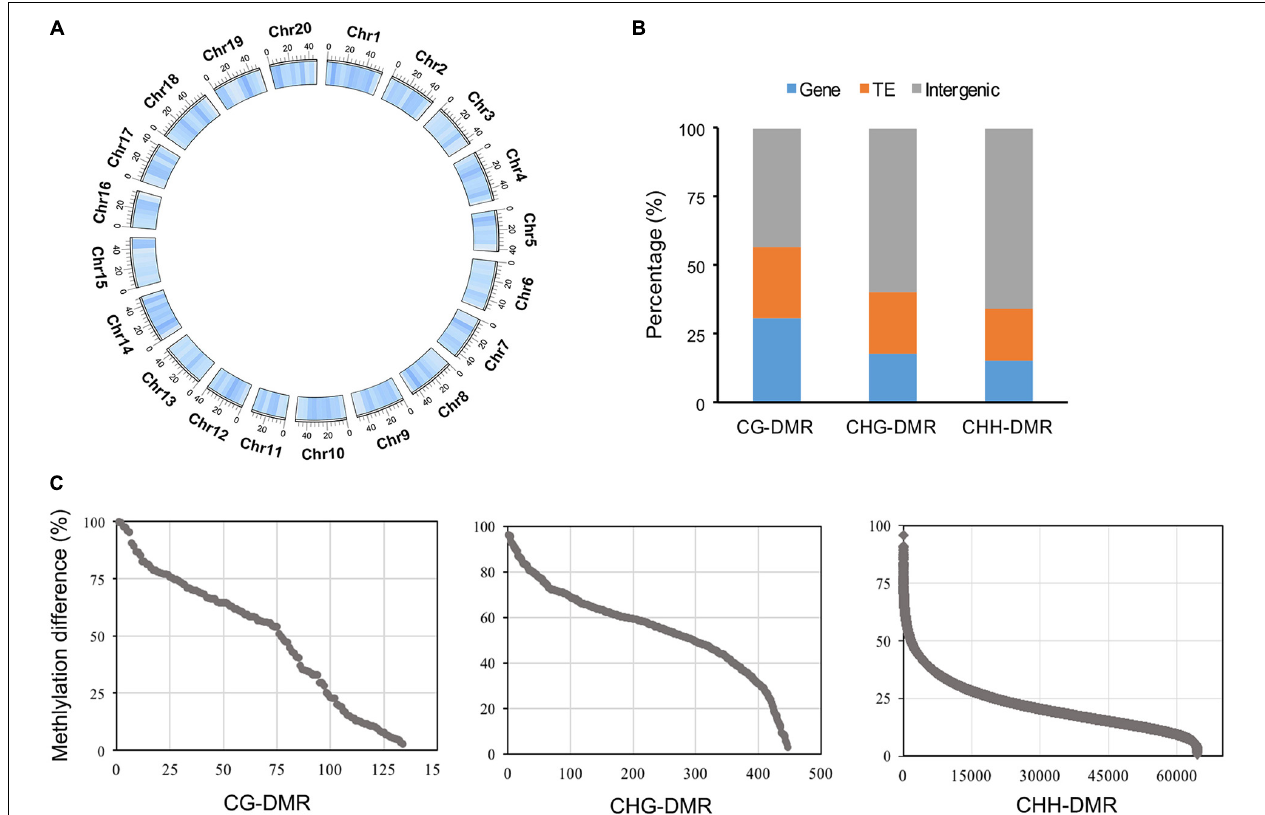
FIGURE 5 | Characteristic features of DMRs in three cytosine contexts. (A) Genome-wide distribution of total DMRs with 5-Mb windows (darker blue indicates high density). (B) Genomic compositions of three different DMR contexts; gene region includes exons, introns, and UTRs. (C) Differences in the methylation level of three different DMR